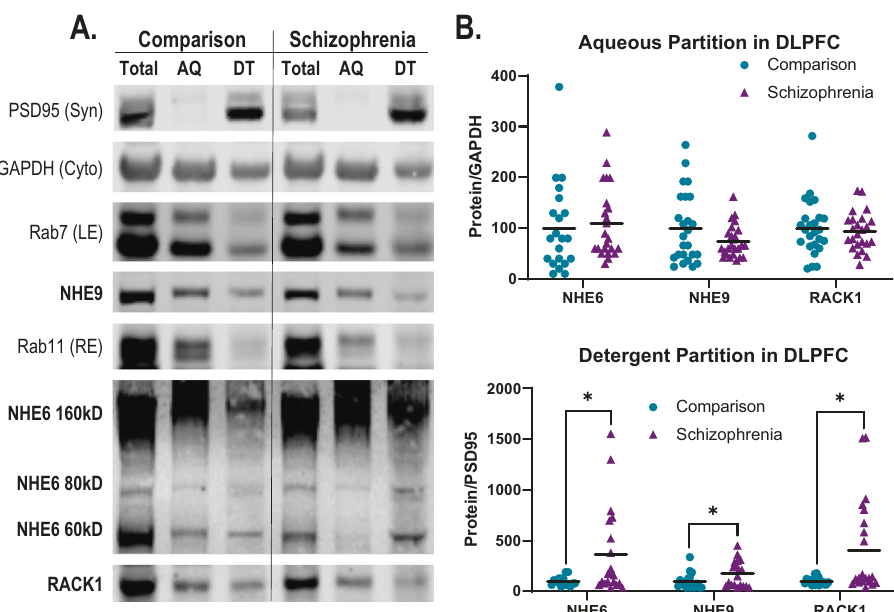
Fig. 4 NHE Triton X-114 (TX-114) phase partitioning in schizophrenia dorsolateral prefrontal cortex (DLPFC). A Representative Western blots demonstrating TX-114 aqueous (AQ) and detergent (DT) phase partitioning of NHE6-NHE9, RACK1, recycling and late endosome markers Rab11 and Rab7, respectively, cytosolic marker GAPDH, and synaptic marker PSD95 in SZ and COMP DLPFC. PSD95 is enriched in the DT fraction while GAPDH, Rab7, and Rab11 are enriched in the AQ fraction. NHE6, NHE9, and RACK1 are present in both AQ and DT fractions but are all present in higher proportion in the AQ fraction. B Quanti fi cation of NHE6, NHE9, and RACK1 TX-114 AQ and DT partitioning in SZ and COMP. For the AQ fraction, NHE6, NHE9, and RACK1 were normalized to intralane GAPDH. NHE6, NHE9, and RACK1 were unchanged in the AQ fraction in SZ DLPFC. For the DT fraction, NHE6, NHE9, and RACK1 were normalized to intralane PSD95. NHE6, NHE9, and RACK1 were all increased in the DT fraction in SZ DLPFC. Lines represent group means. * p < 0.05. AQ aqueous phase, DT detergent phase, Syn synaptic marker, Cyto cytosolic marker, LE late endosome marker, RE recycling endosome